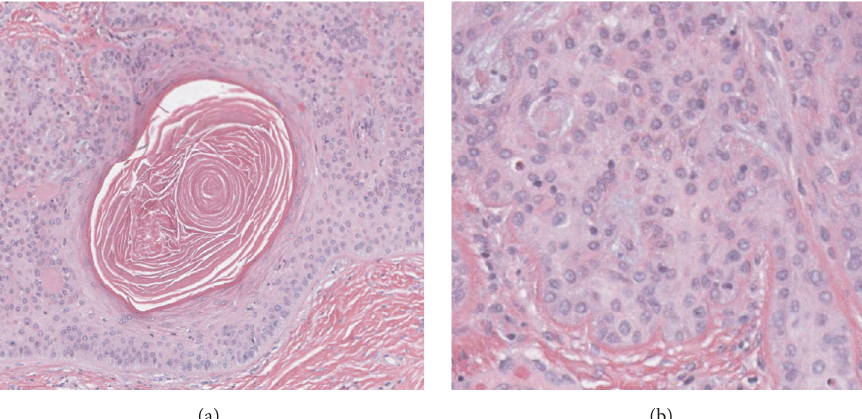
Figure 2: Higher power (20x) shows a keratocyst with no visible granular layer and abrupt keratinization (a). The pale pink cytoplasm of tumor cells is evidence of tumor glycogenation and the characteristic differentiation